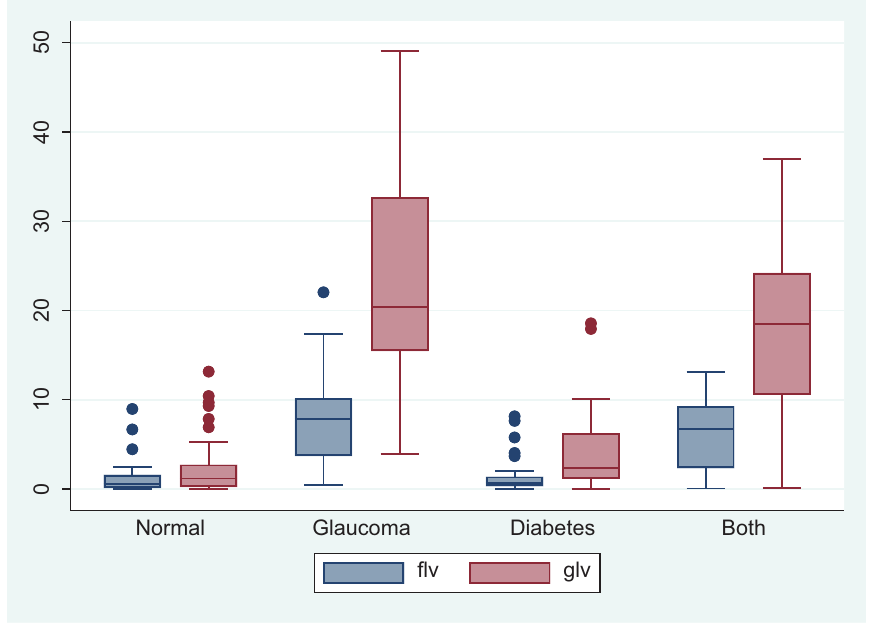
Figure 1. The mean values for ganglion cell complex (GCC) thickness in patients with glaucoma, diabetes, both (diabetes and glaucoma), and none (172 eyes).